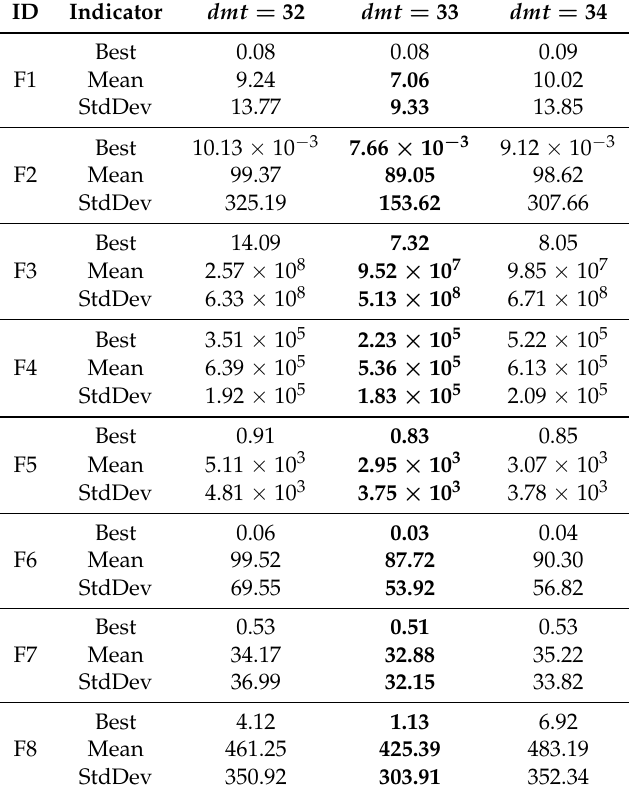
Table 6. Experiments with varying dmt parameter value of the MBO-ABC for benchmarks with 30 dimensions (bold style is used to indicate better